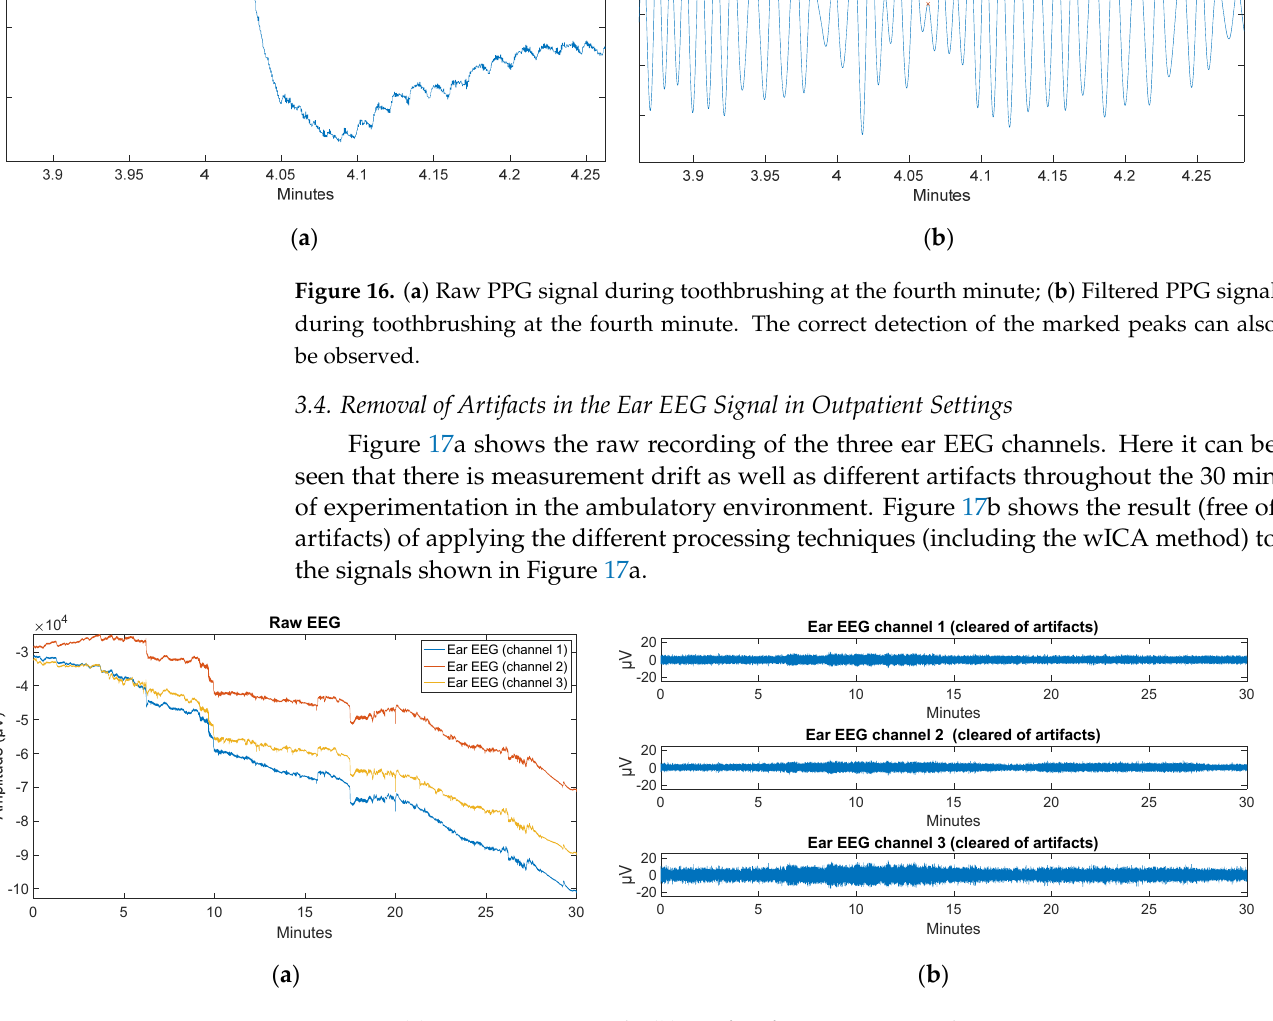
user was doing a sudoku (concentration activity, task 7), a power increase can be again observed in the beta band. A sharp power drop is also observed in both figures from 40 Hz onwards due to the bandpass filter up to this frequency.